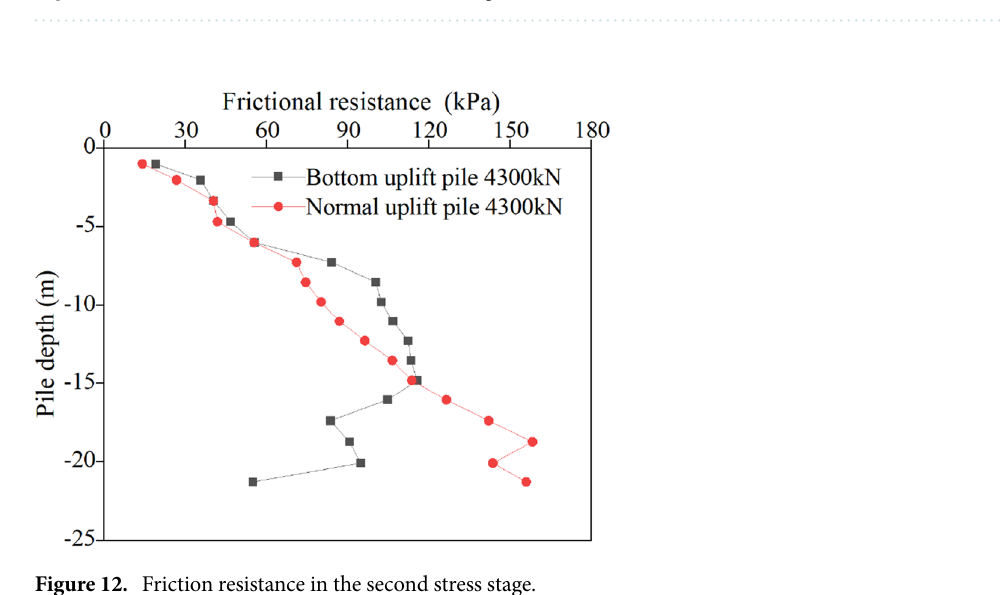
Figure 11. Friction resistance in the first stress stage.